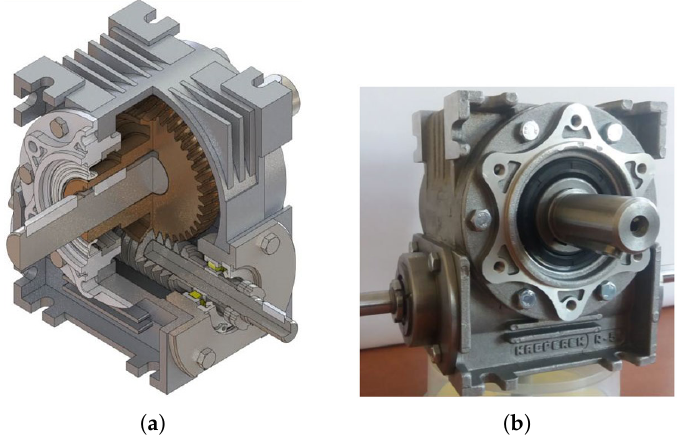
Figure 15. Worm gear drive with locally axially adaptive worm as experimental subject. ( a ) Worm gear drive model. ( b ) WG2 worm gear drive used in experimental research.